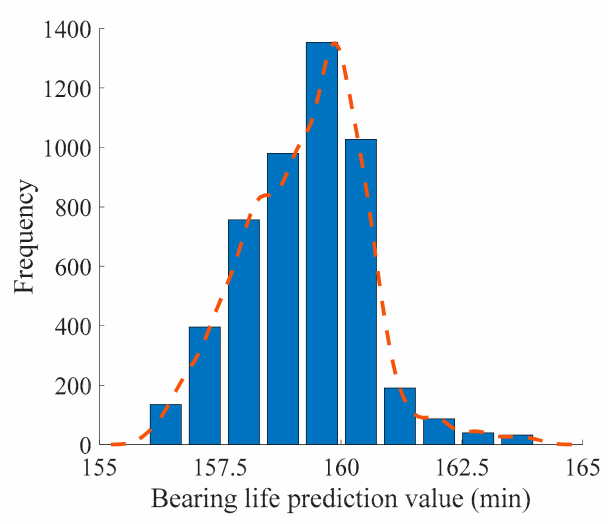
Figure 6. Posteriori distribution diagram of bearing predicted life (predicted time k = 110). After the prediction update, the posterior distribution of bearing RUL is composed of 5000 samples. The probability distribution of the posterior sample is shown in Figure 7. Inspection numbers 1 to 10 correspond to the prediction time series 68, 78, 88, . . . , 158. The posteriori samples are represented by the probability density of the normal distribution and the expectation of each posteriori distribution is taken as the final prediction